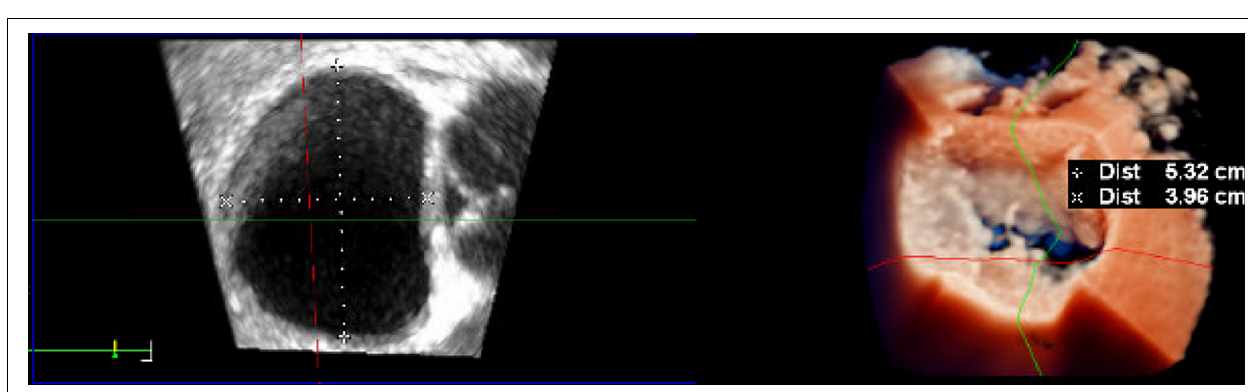
22% (from 153 ± 41 ml to 119 ± 28) at 1-year follow-up (37).